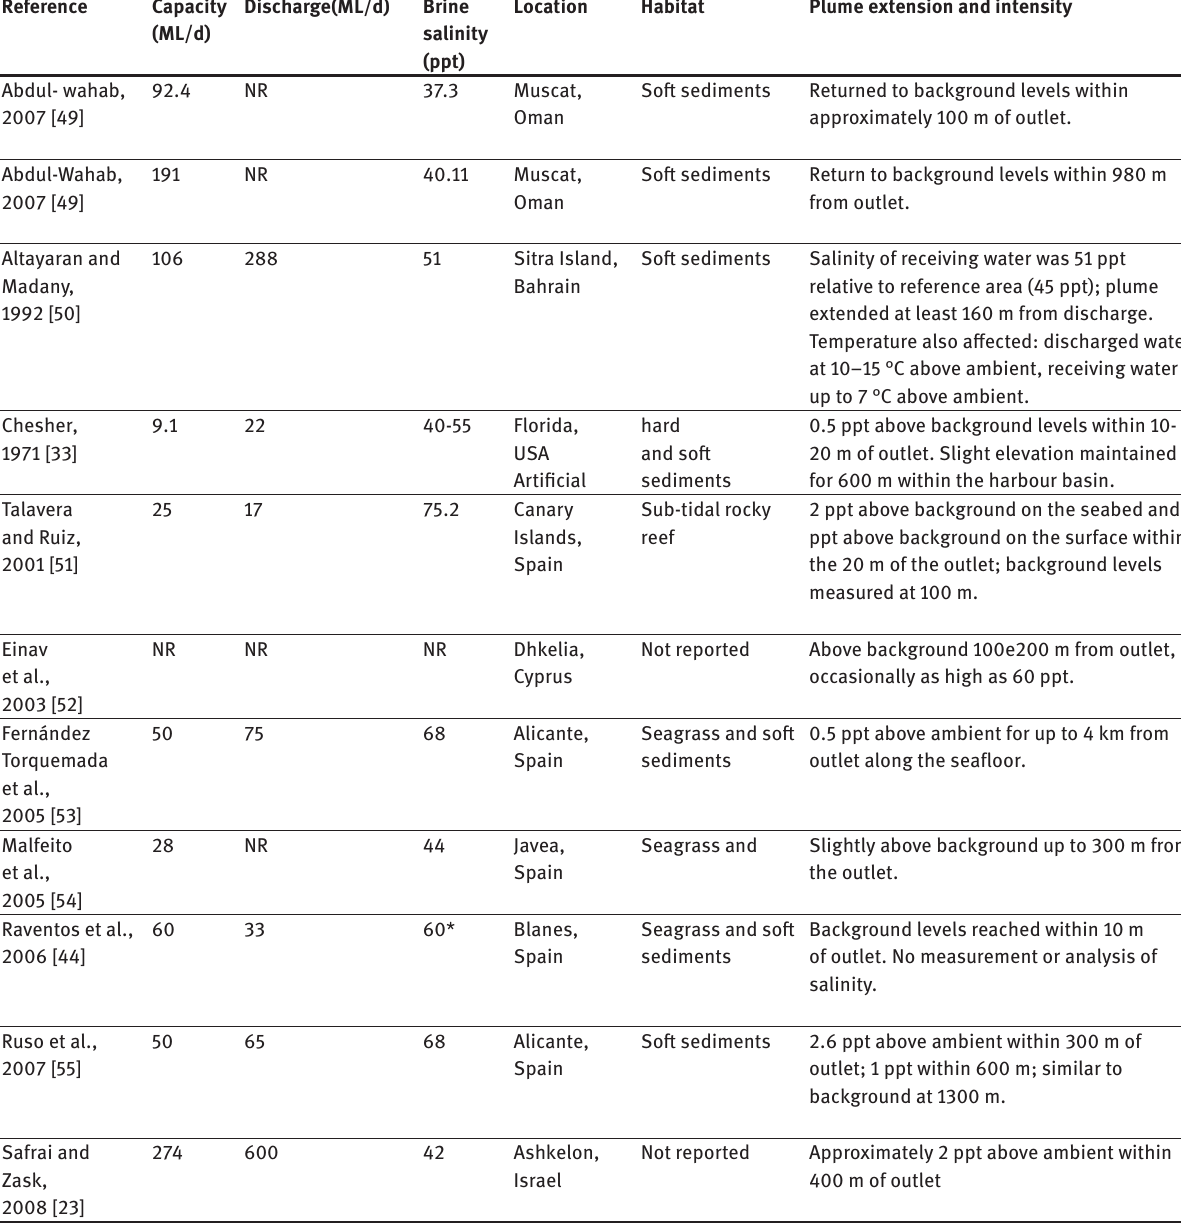
Table 1: Extent and intensity of brine plumes in receiving waters surrounding desalination plant Discharge outlets.